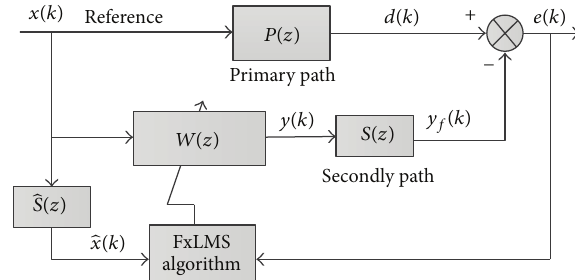
Figure 11: The structure of FxLMS